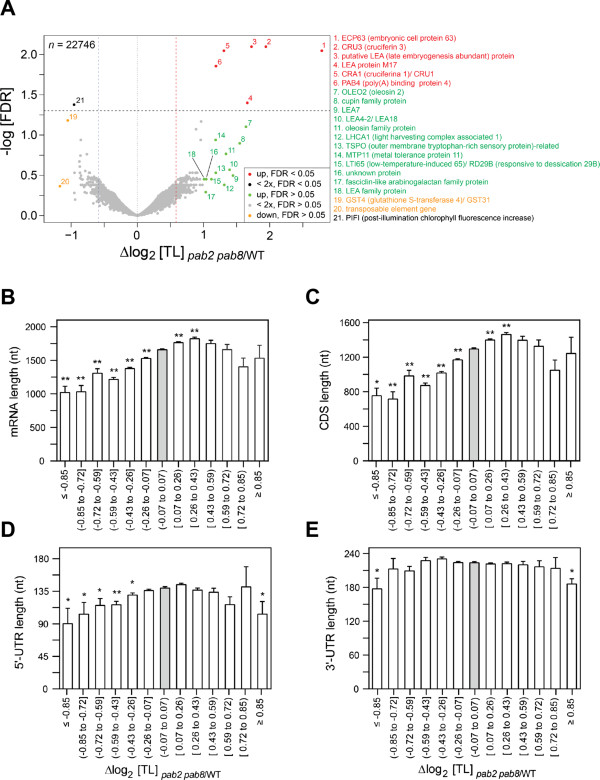
Translation states (TL) in the pab2 pab8 poly(A) binding protein mutant. Δlog2 TL indicates translational stimulation (>0) or inhibition (<0) in the pab2 pab8 mutant as compared to wild-type. (A) Volcano plot showing the distribution of alterations in ribosome occupancy (x-axis) versus the false discovery rate (FDR, y-axis). Many of the translationally stimulated mRNAs encode seed storage proteins. The color coding distinguishes mRNAs with FDR-validated significance (red for upregulated, black for downregulated) from mRNAs showing trends only (green for upregulated, orange for downregulated). Genes above the stippled line are less than 5% likely to be false positives. (B-E) The effect of the pab mutation on ribosome occupancy is related to mRNA length (B), specifically the lengths of the coding sequence (C) and 5′ untranslated region (UTR) (D), rather than the 3′ UTR (E). Asterisks indicate a significant difference compared to the gray 'no change’ bin (Student t test); **P <0.0001; * ≥ 0.0001 P <0.05. Error bars are standard errors of the mean.